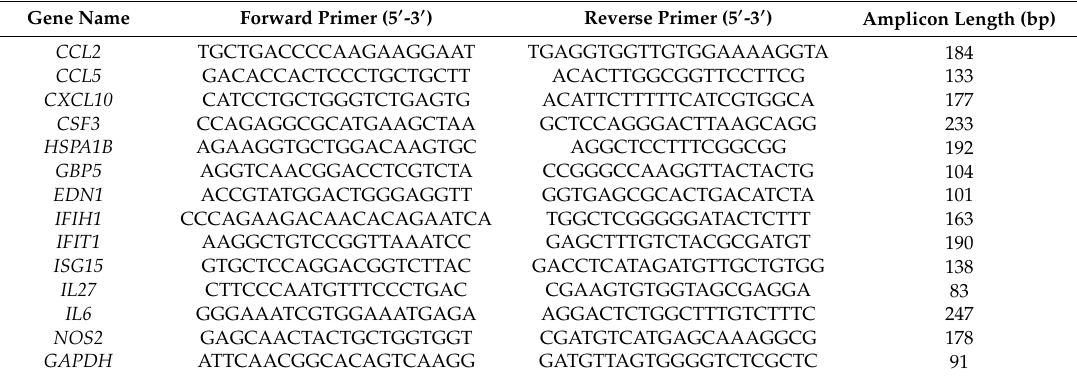
Table 5. List of primers used for qRT-PCR